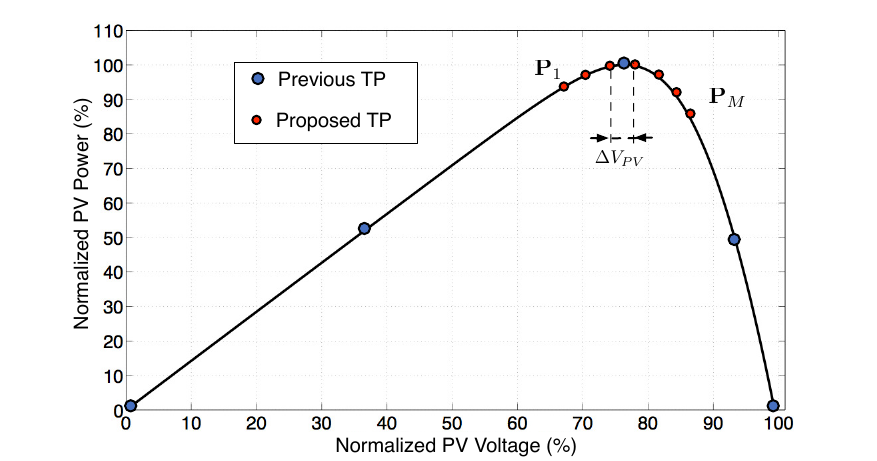
Figure 2. Test points’ selection (TP) for calculating the fitness